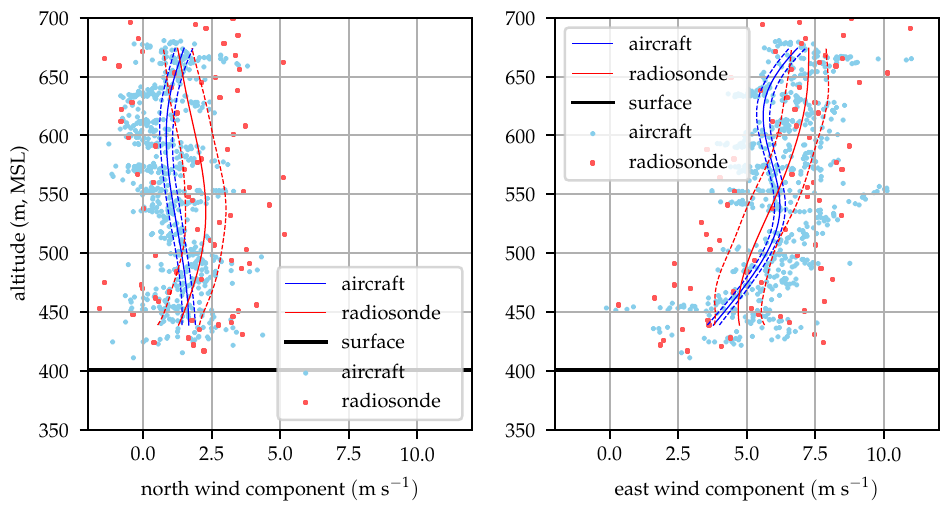
Figure 14. Aircraft and radiosonde profiles from 08:00 local time (2018-12-06). Solid lines represent the mean profile estimated by the aircraft and radiosonde while dashed lines represent the 1 σ error bounds. The raw aircraft and radiosonde observations are depicted with scattered points.